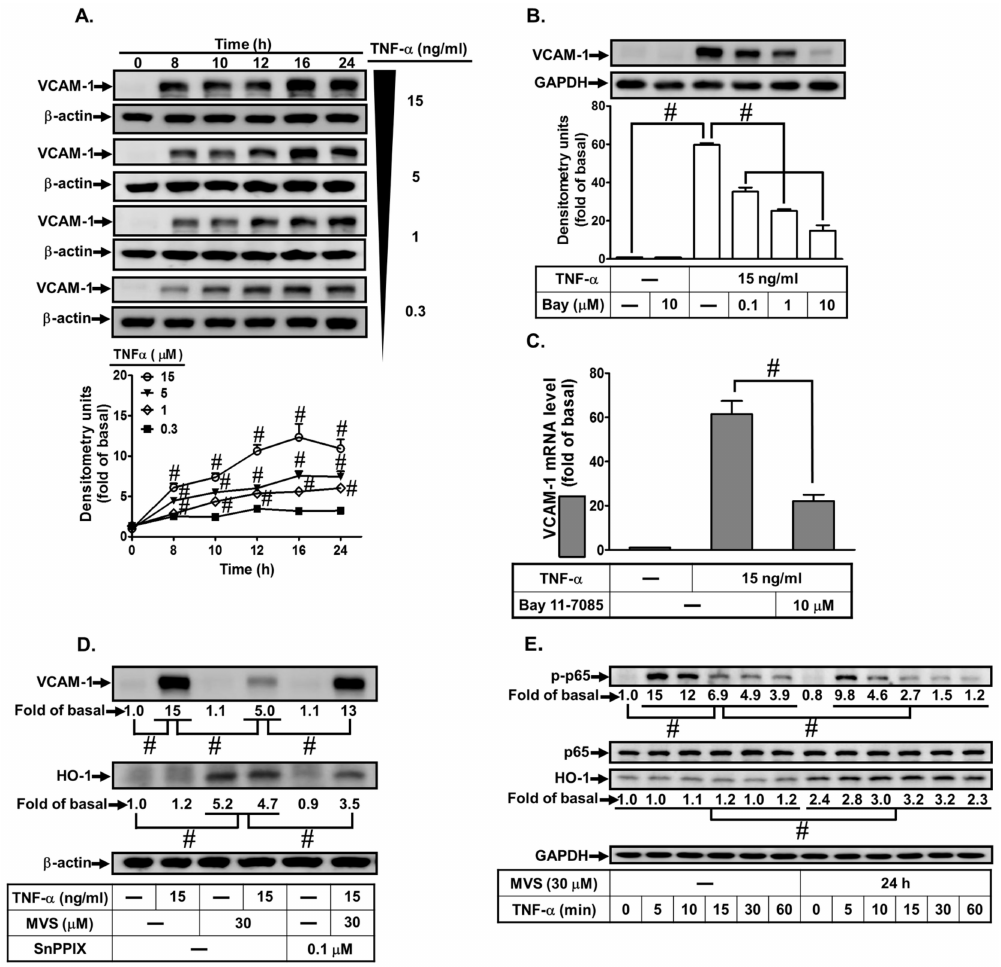
Figure 1. Mevastatin (MVS)-induced heme oxygenase (HO)-1 expression attenuates tumor necrosis factor α (TNF α )-stimulated phosphorylation of NF- κ B p65 and VCAM-1 expression. ( A ) Human pulmonary alveolar epithelial cells (HPAEpiCs)s were incubated with di ff erent concentrations of TNF α (15, 5, 1, or 0.3 ng / mL) for the indicated time intervals. ( B , C ) Cells were pretreated di ff erent concentrations of Bay11-7082 (0.1, 1, or 10 µ M) for 1 h, and then incubated with or without TNF α (15 ng / mL) for 24 h (protein) or 4 h (mRNA). ( D ) HPAEpiCs were pretreated with 30 µ M MVS for 1 h, incubated with or without tin protoporphyrin IX (SnPPIX) (0.1 µ M) for 1 h, and then stimulated with TNF α for 24 h. ( E ) Cells were pretreated with 30 µ M MVS for 24 h and then incubated with TNF α (15 ng / mL) for the indicated time intervals. ( A , B , D , E ) The levels of VCAM-1, β -actin, glyceraldehyde 3-phosphate dehydrogenase (GAPDH), phospho-p65, p65, and HO-1 protein were determined by Western blot using respective antibodies as indicated. Data are expressed as mean ± SEM of five independent experiments ( n = 5). # p < 0.01, as compared with the cells exposed to the indicated